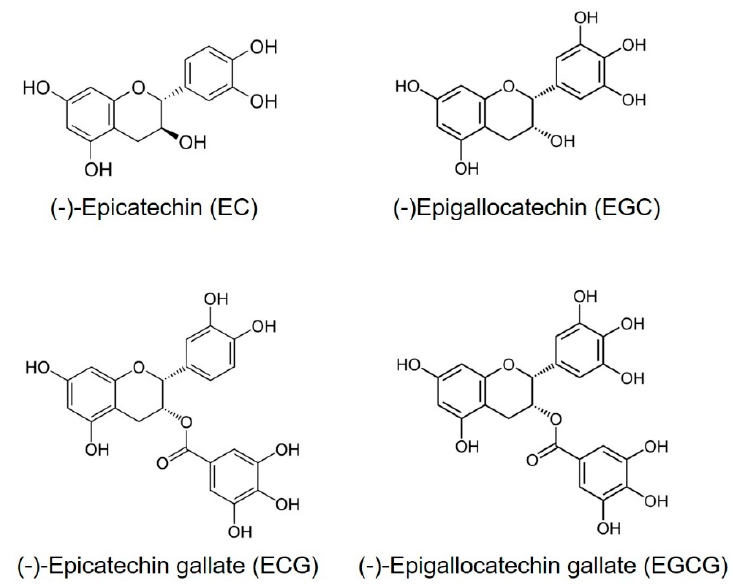
Figure 1. Chemical structures of major polyphenols present in green tea.